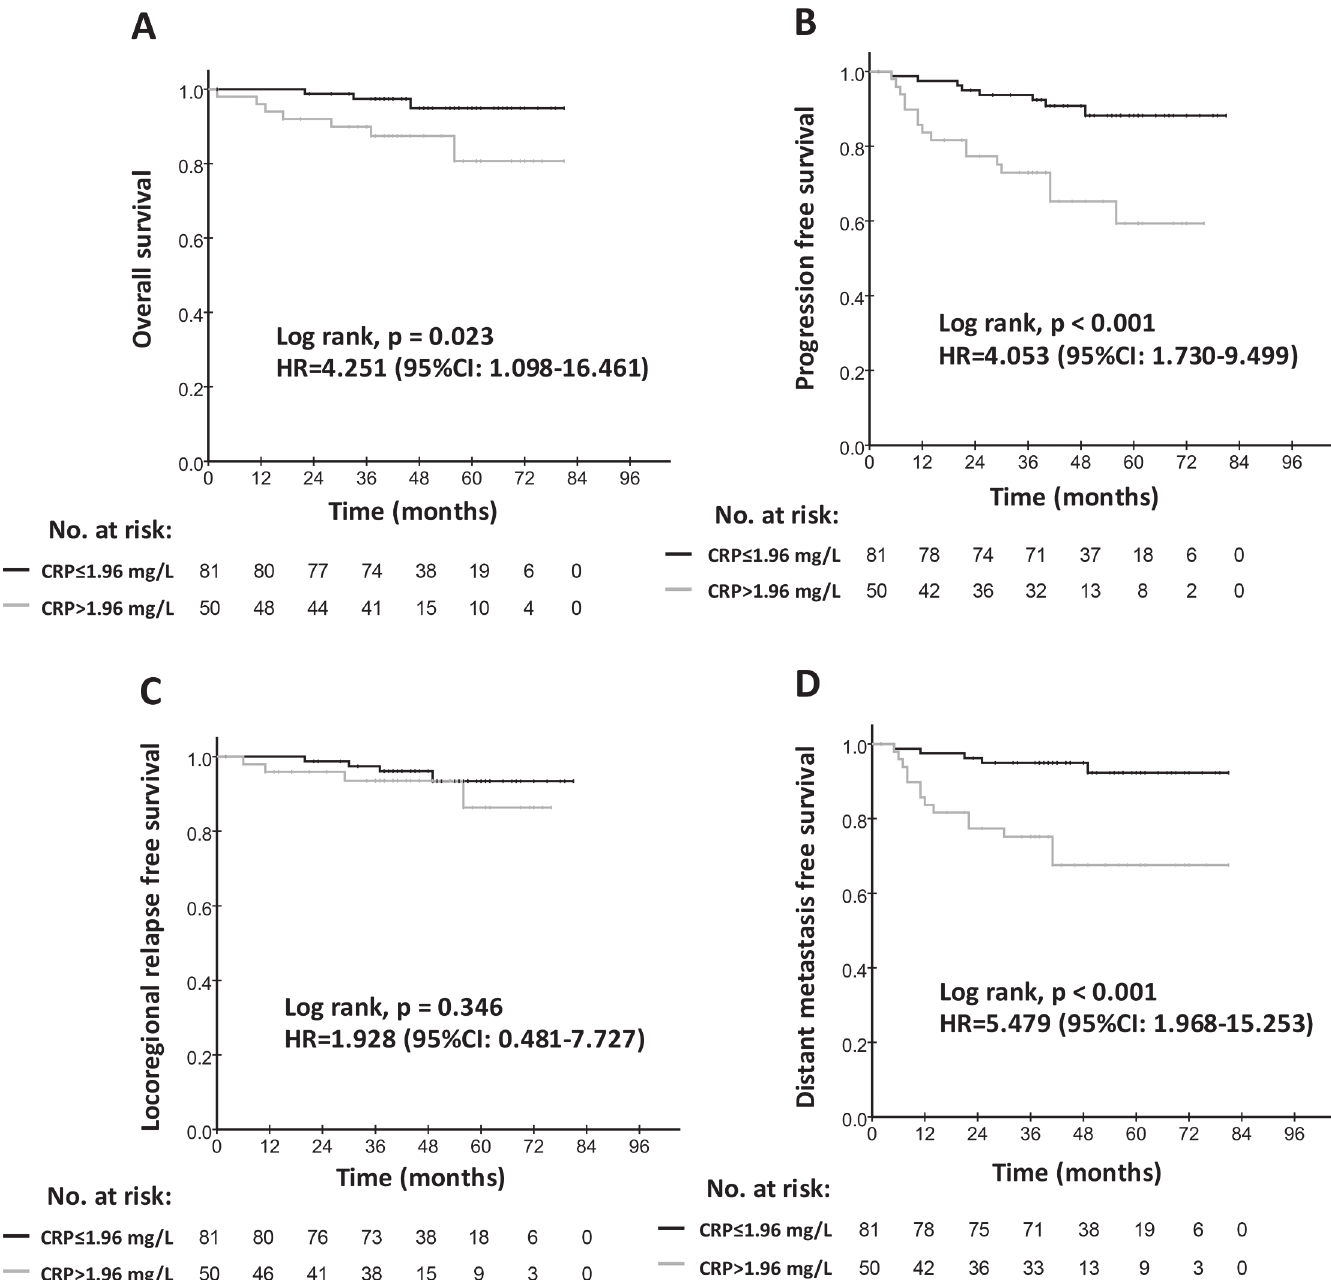
Fig 3. Kaplan-Meier survival curves for the low hs-CRP group ( (cid:3) 1.96 mg/L) and the high hs-CRP group ( > 1.96 mg/L) in patients with chronic HBV infection. Overall survival rates (A), progression-free survival rates (B), locoregional relapse-free survival (C) and distant metastasis-free survival rates (D) were compared in the subgroup of NPC patients with chronic HBV infection. Hazards ratios (HRs) were calculated using the unadjusted Cox proportional hazards model. P values were calculated using the unadjusted log-rank